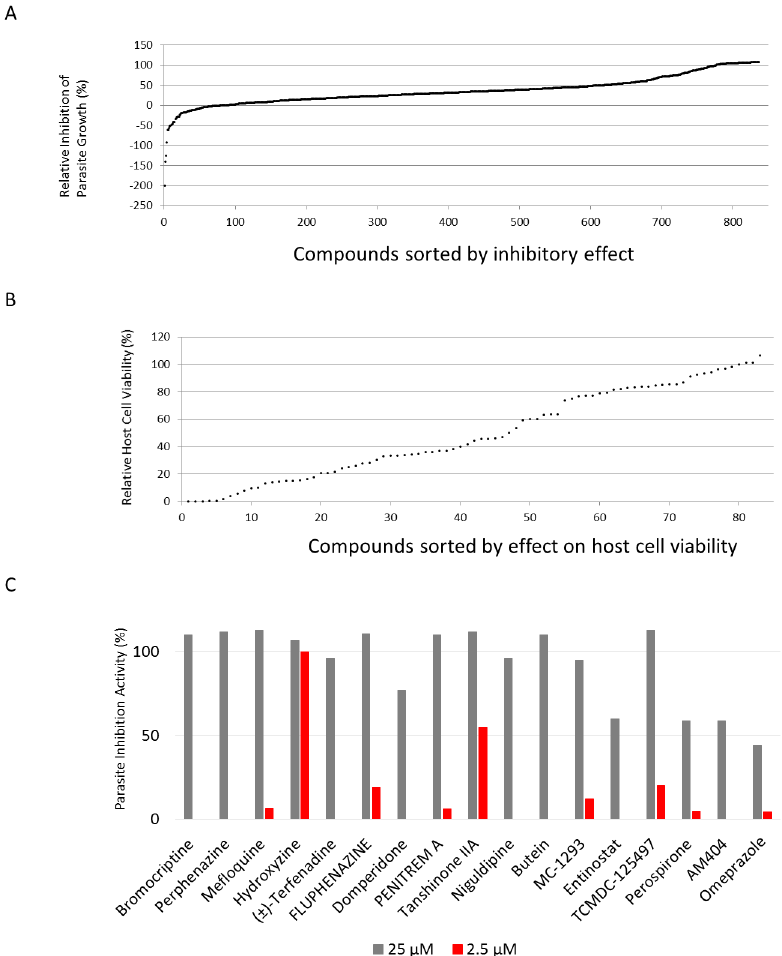
Fig 1. Primary screening for anti- Toxoplasma activity and cytotoxicity. (A) PLK/DLUC_1C9-infected Vero cells were incubatedwith 10 μ M test compounds(837 compounds) for 48 h (see Materials and Methods). Renillaluciferase, expressedby PLK/DLUC_1C9 T . gondii ,was measured, and inhibitionwas calculatedwith DMSO as a negativecontrol (0% inhibition)and 10 μ M pyrimethamine as a positive control (100% inhibition).Compounds in the plates that had a Z’-value (cid:21) 0.5 are presented sorted by inhibitoryeffect. (B) Compounds that showed (cid:21) 90% parasiteinhibition(83 compounds)were then screened for effects on host cell viability(see Materials and Methods). Compounds were screenedat a concentration of 10 μ M. Cell viabilityvalues were calculatedrelative to backgroundvalues (0% viability)and the DMSO negative control (100% viability). (C) Parasite growth inhibitionactivities were shown at 25 μ M(gray bars) and 2.5 μ M(red bars). Tanshinone IIA and hydroxyzinehad > 50% growth inhibitoryeffect on parasites.